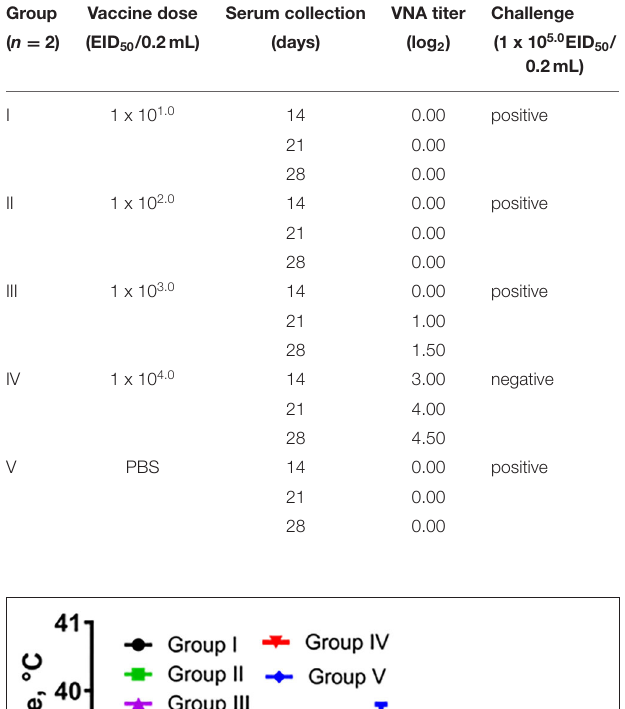
TABLE 3 | Dynamics of VNA formation in sera after immunization with the vaccine and protectiveness after challenge with the virulent virus. Group Vaccine dose VNA titer